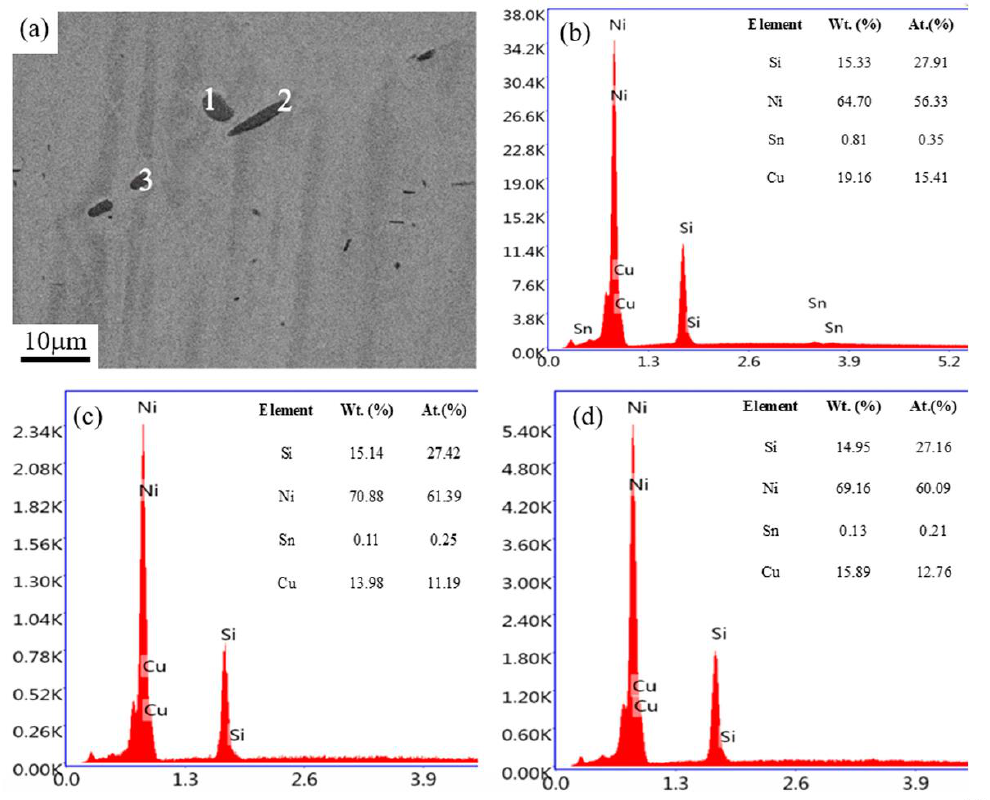
Figure 7. Metallographic images of the solution-treated sample of the Cu–6Ni–6Sn–0.6Si alloy: ( a ) low magnification and ( b ) high magnification.